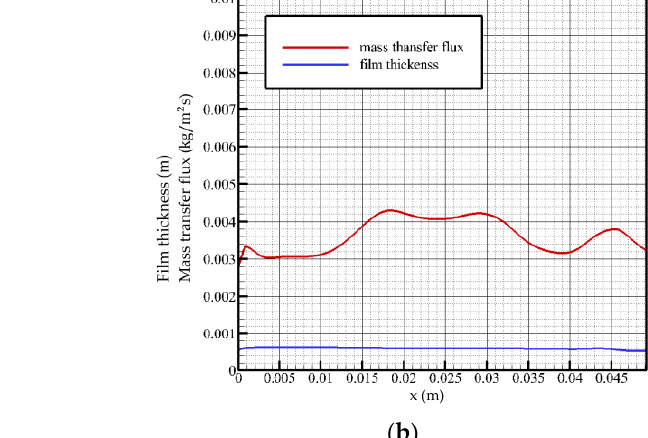
( b ) Figure 5. Mass transfer flux and liquid film surface height as a function of flow distance, Re = 20. ( a ) t = 0.58 t 0 , ( b ) t = 2 t 0 . When the Reynolds number is 40 and the flow time is t = 0.76 t 0 , as shown in Figure 6a, near the flow inlet, the mass transfer flux on the surface of the liquid film increases gradually. When the surface of the liquid film fluctuates, the mass transfer flux changes from a gentle change to a downward trend, and a local minimum occurs when the flow distance reaches the wavefront region ( x ≈ 0.028 m), where the absorption strength of steam is weak. When reaching the trough position, the mass transfer flux turns to rise and has a local maximum value and then drops sharply with the steeply rising liquid film surface height. The thickness of the liquid film in the leeward side area decreases as a